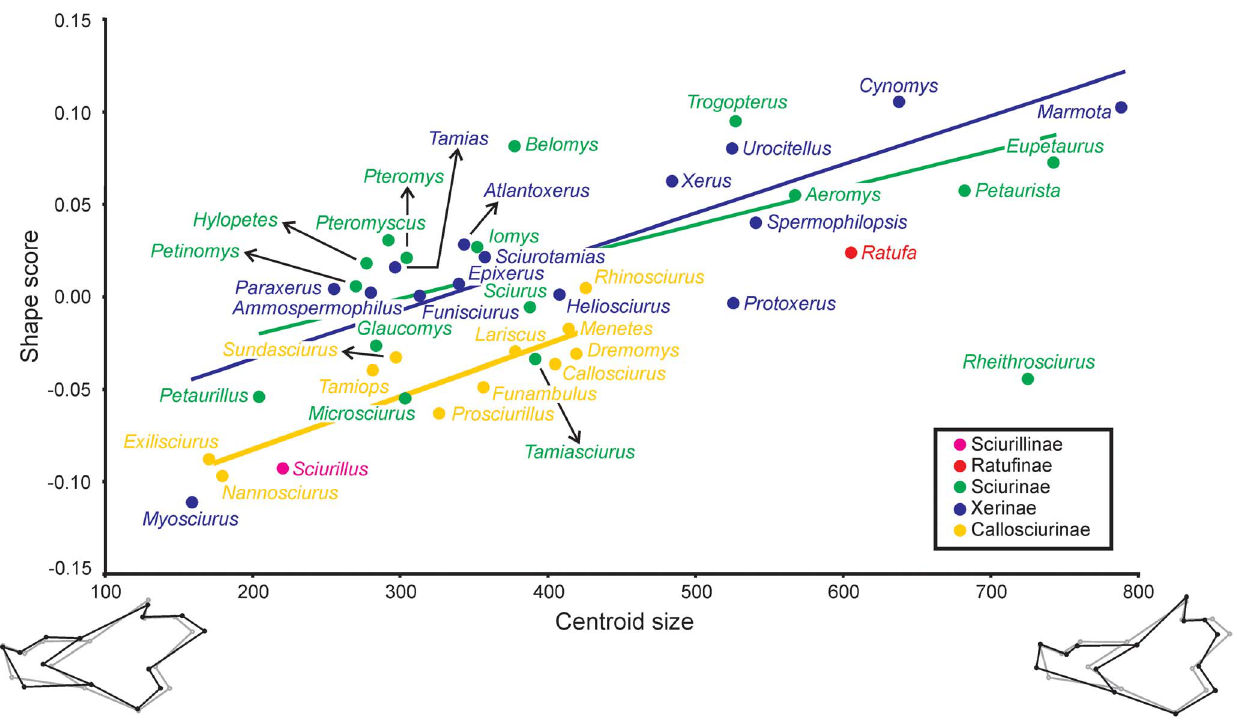
Figure 2. Shape change associated with evolutionary allometry estimated from regression of shape on centroid size. Regression analyses for each one of the squirrel subfamilies. Differences in the intercept and slope are tested using ANCOVA (see text for details). Only genera means are shown.